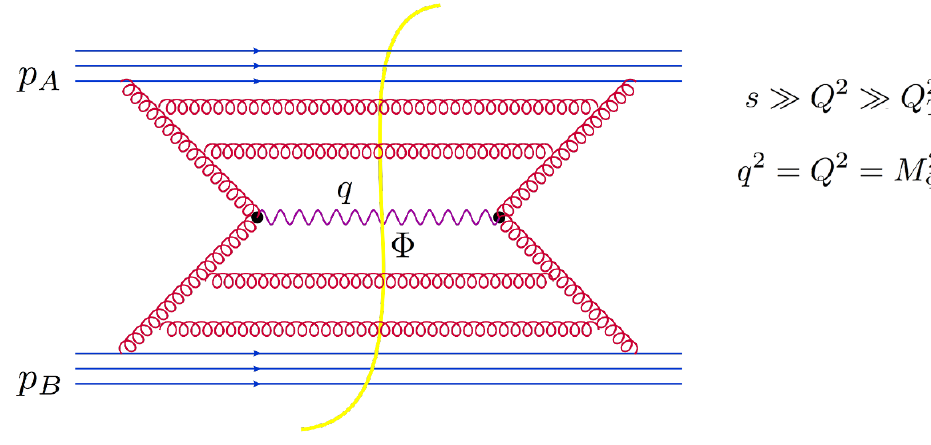
Figure 1 . Particle production by gluon-gluon